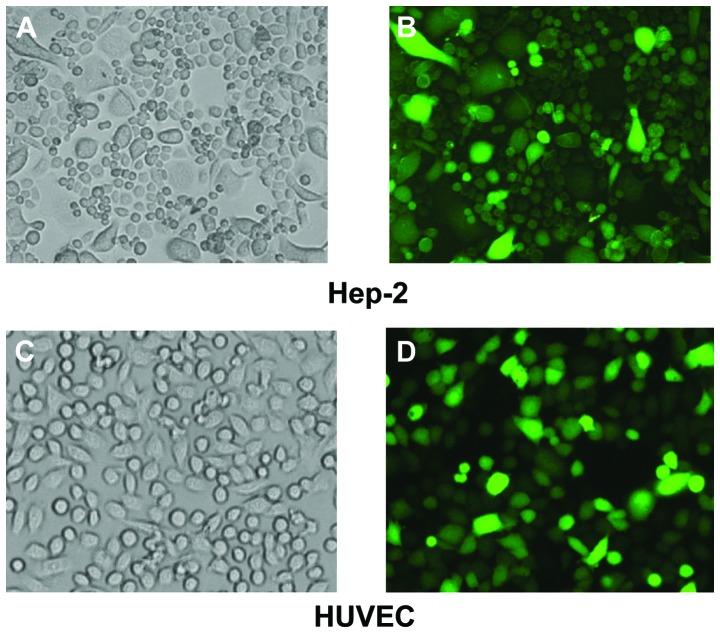
Morphological changes in Hep-2 cells and HUVECs infected with Ad-hIL-24. Hep-2 cells infected with Ad-hIL-24 at 48 h under (A) ordinary optical and (B) fluorescence microscopy. HUVECs infected by Ad-hIL-24 at 48 h under (C) ordinary optical and (D) fluorescence microscopy (magnification, ×200). HUVECs, human umbilical vein endothelial cells.